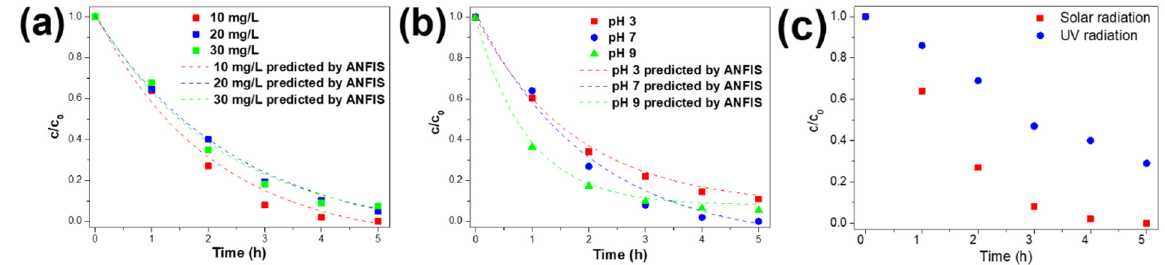
Figure 6. Effect of ( a ) initial MNZ concentration, ( b ) pH, and ( c ) solar as well as UV lamp radiation on the photocatalytic degradation of MNZ.